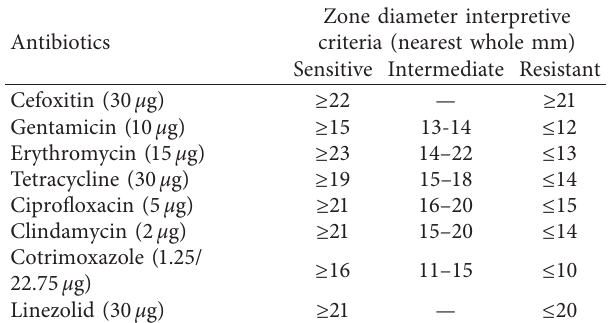
Table 13: Zone diameter interpretative standard for S. aureus